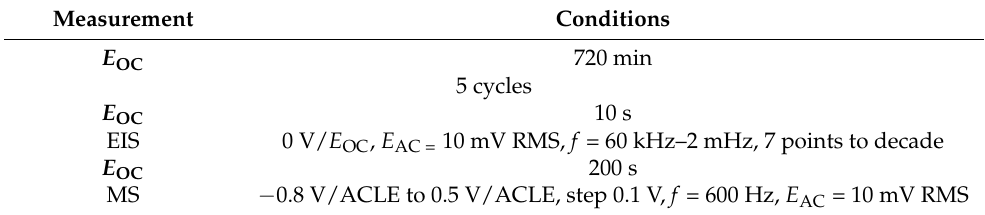
Table 1. The measurement scheme of electrochemical response on change of pH.